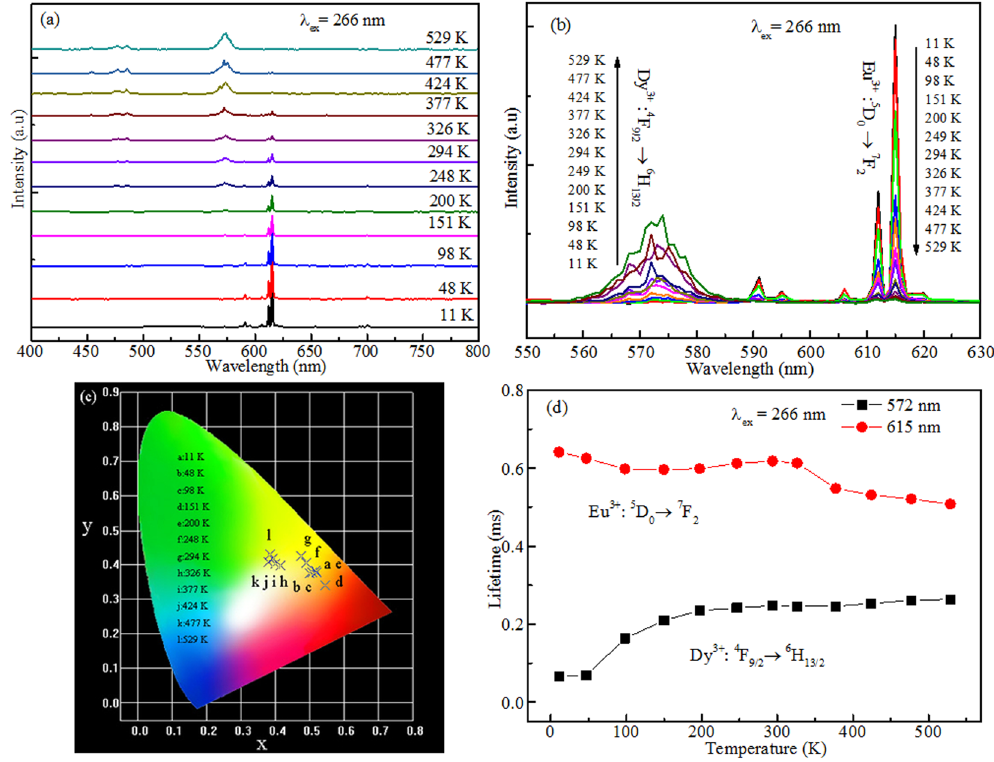
Figure 7. ( a ) PL Emission spectra, ( b ) Temperature-dependent spectra at 572 nm and 615 nm, ( c ) CIE, ( d ) Calculated lifetimes of 4 F 9/2 (Dy 3 + ) and 5 D 0 (Eu 3 + ) energy levels of Dy 3 + and Eu 3 + ions of the SrWO 4 : 0.4 mol% Eu 3 + , 4 mol% Dy 3 + phosphor under 266 nm excitation from 11 K to 529